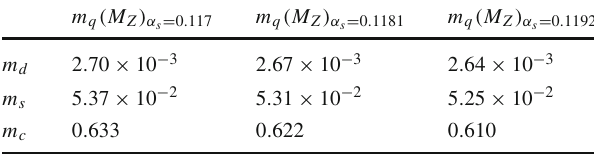
Table 4 Quark Masses (in GeV) at M Z in the DR Prescription m q ( M Z ) α s = 0 .